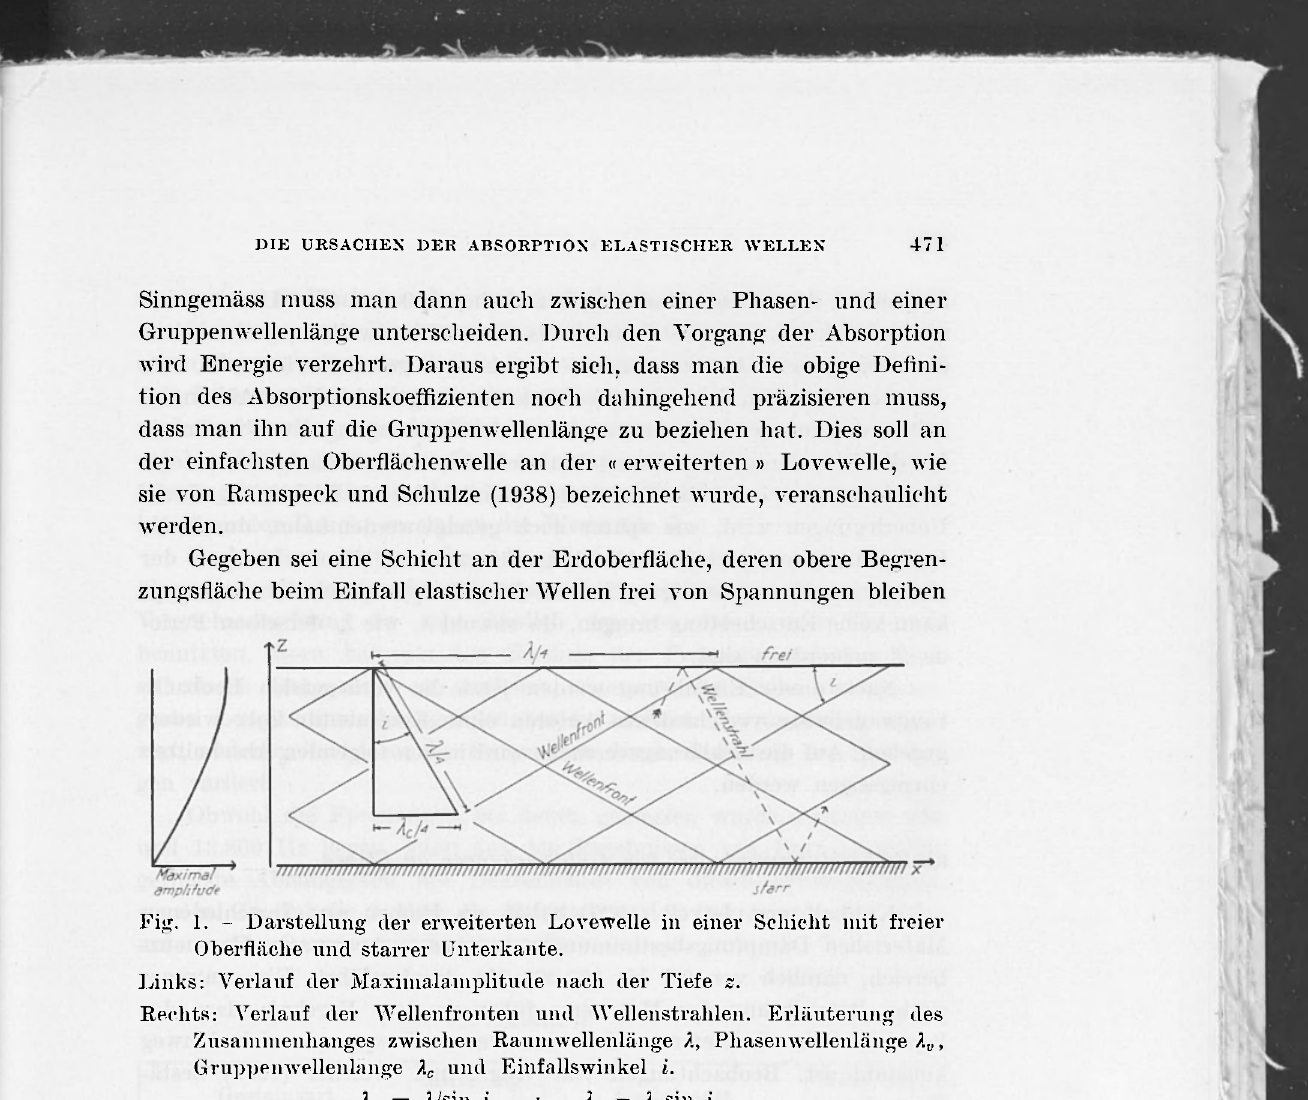
Fig. 1. - Darstellung der erweiterten Lovewelle in einer Schicht mit freier Oberflàche und starrer Unterkante. Links: Verlauf der Maximalamplitude nach der Tiefe